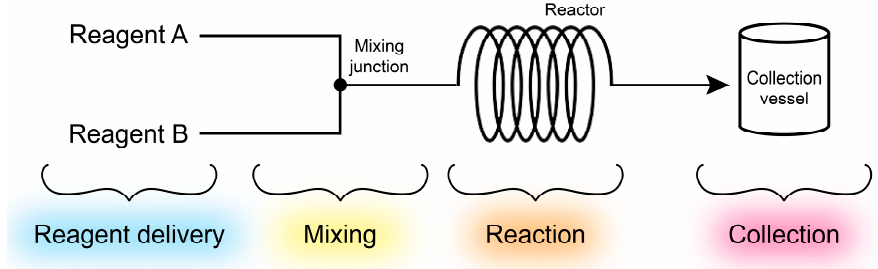
Figure 12. Key elements of a continuous flow system, redrawn from [94] (p. 11). There are, however, notable challenges with the current continuous flow